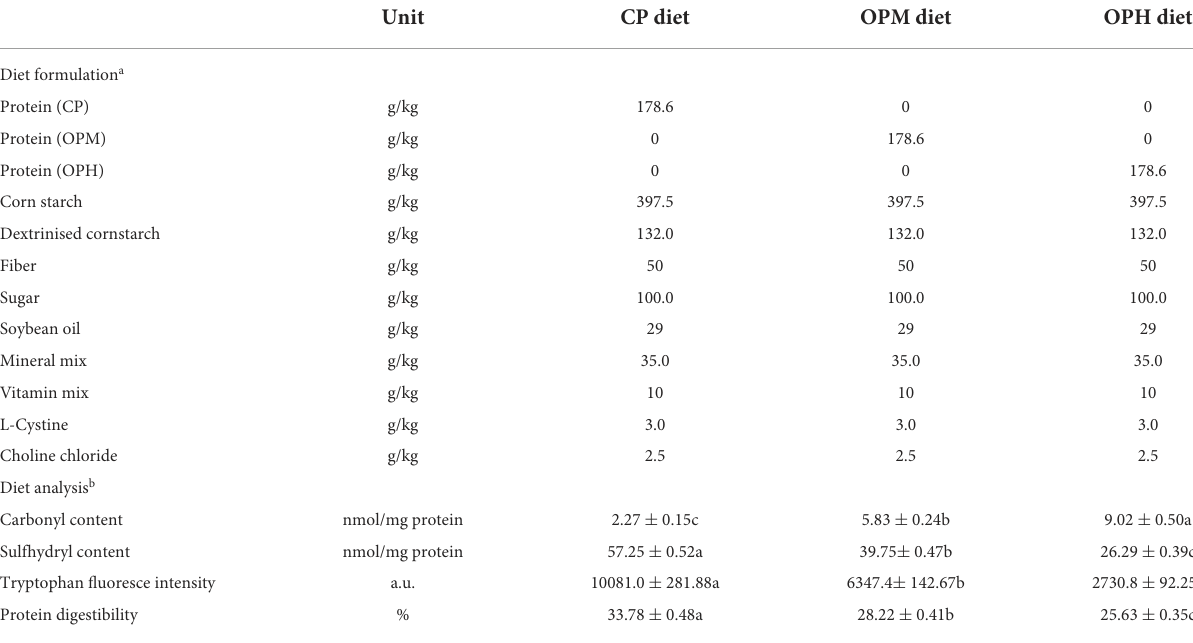
TABLE 1 Compositions and analysis of experimental